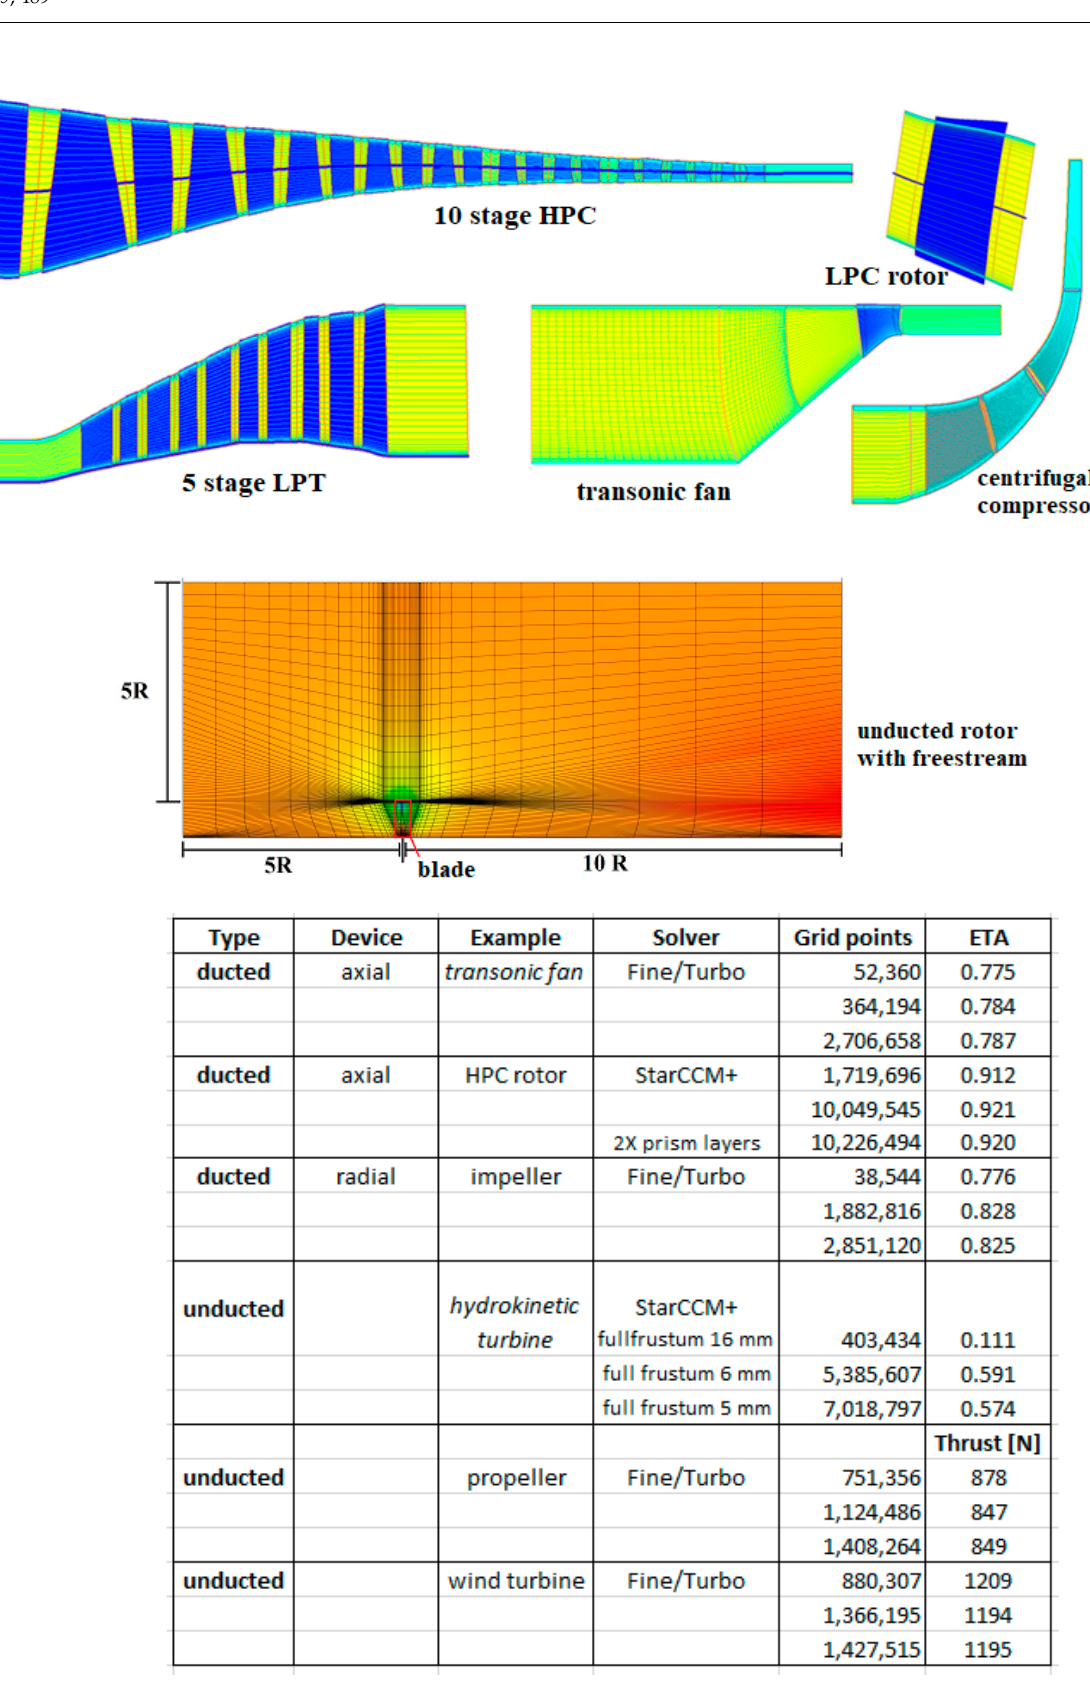
Figure 17. Axisymmetric views of 3D domains for ducted axial 10-stage HPC, 5-stage LPT, solo LPC rotor, centrifugal compressor novel configuration, and unducted rotors without nose at hub. Grid dependency for listed examples of configurations are also listed in the bottom